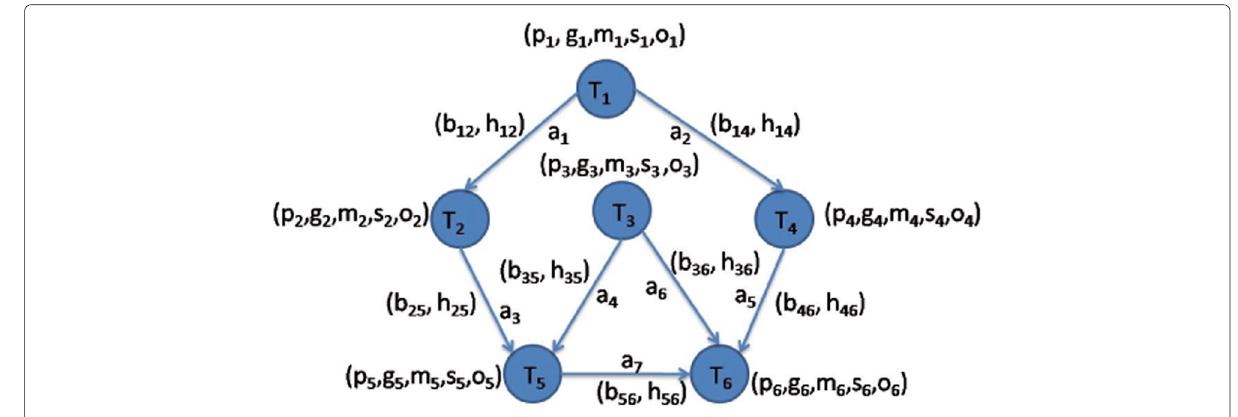
Fig. 2 Task dependencies